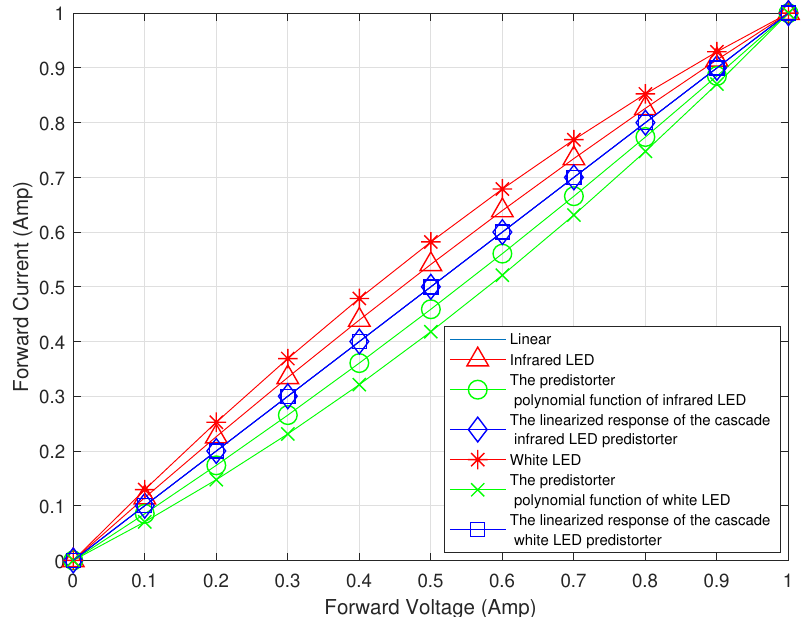
Figure 4. Nonlinear, predistortion, and linearized LED transfer